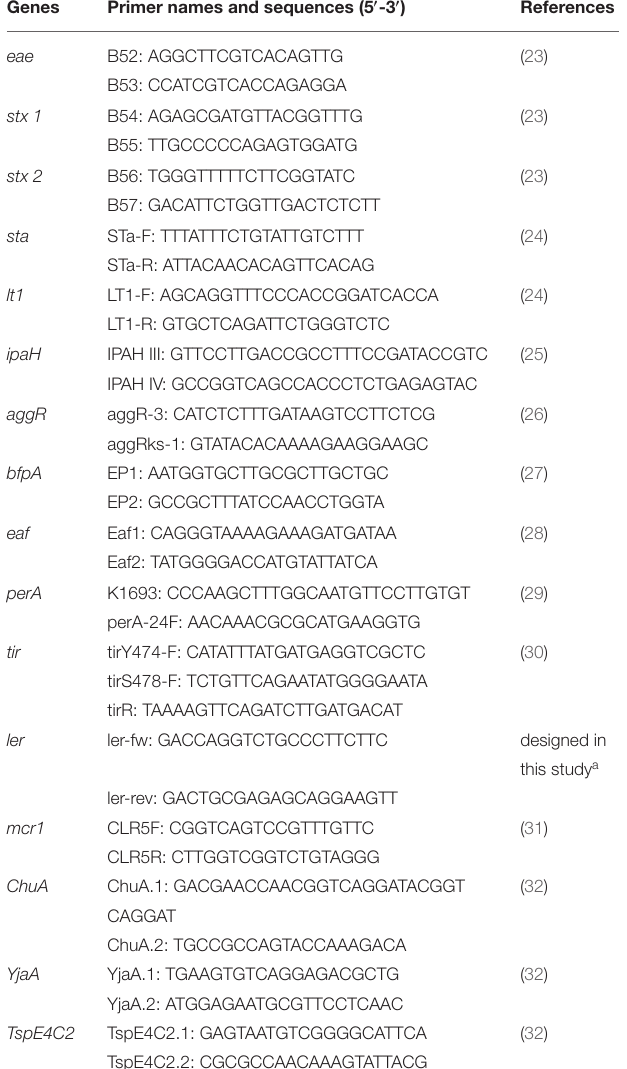
TABLE 1 | Used primers for PCR with their